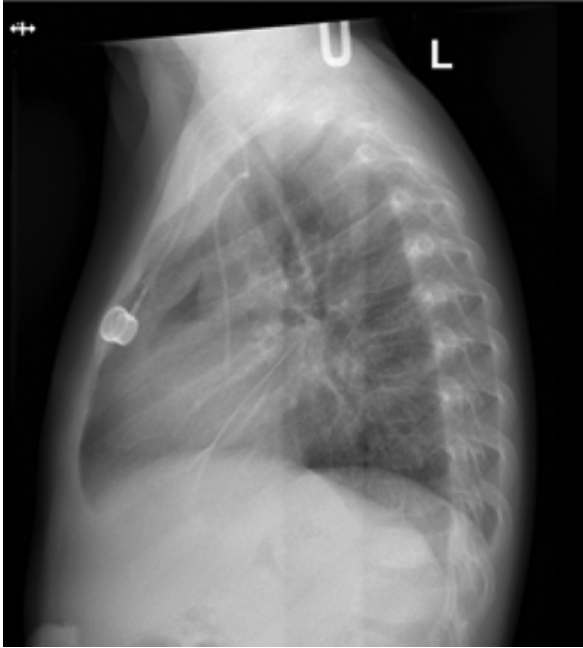
Fig. 1 Lateral view of chest X-ray on day 0 postesophageal dilatation demonstrating lucency in the middle mediastinum, which is sug- gestive of esophageal